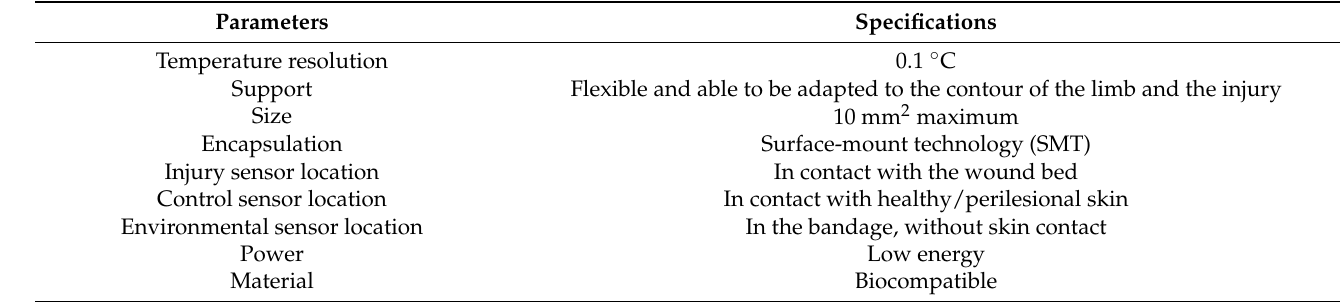
Table 2. Temperature sensor